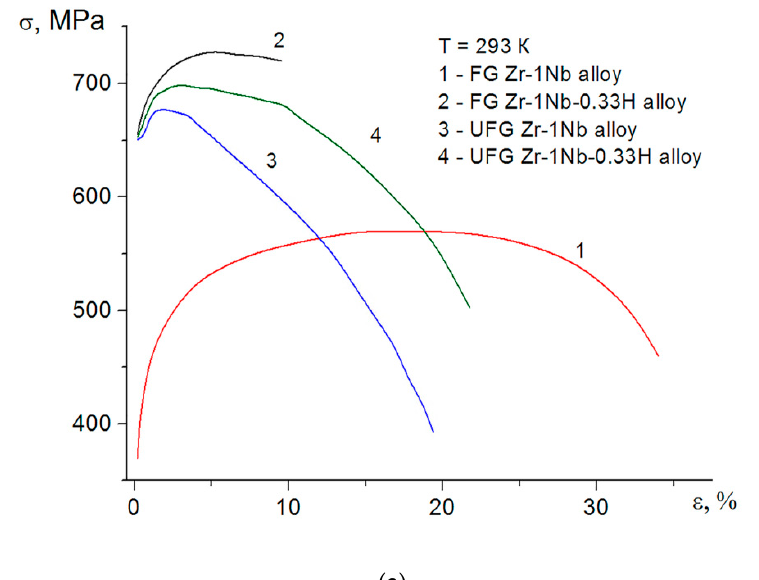
Figure 6. Temperature dependence of the change in the average grain size of the UFG structure of the zirconium